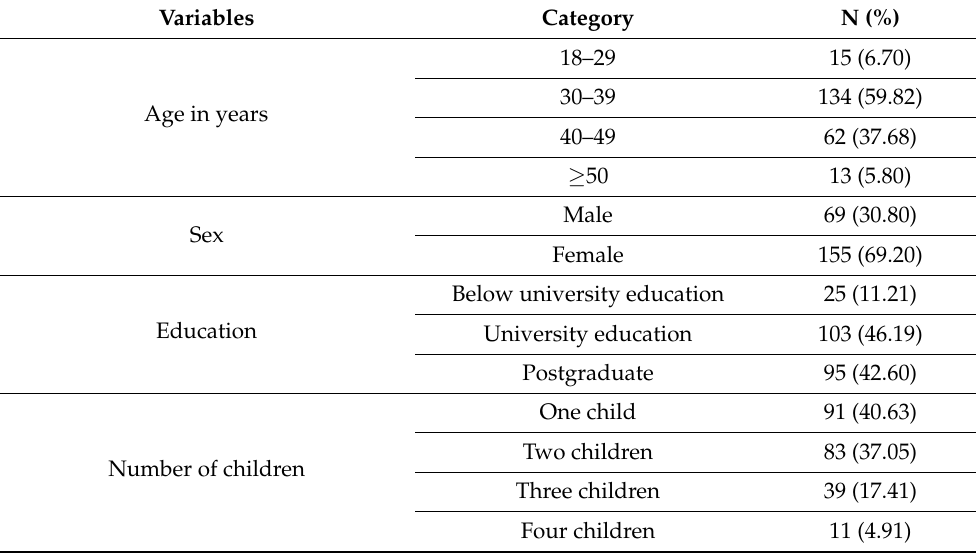
Table 1. Baseline characteristics of the study population and the Parent Attitudes About Childhood Vaccines